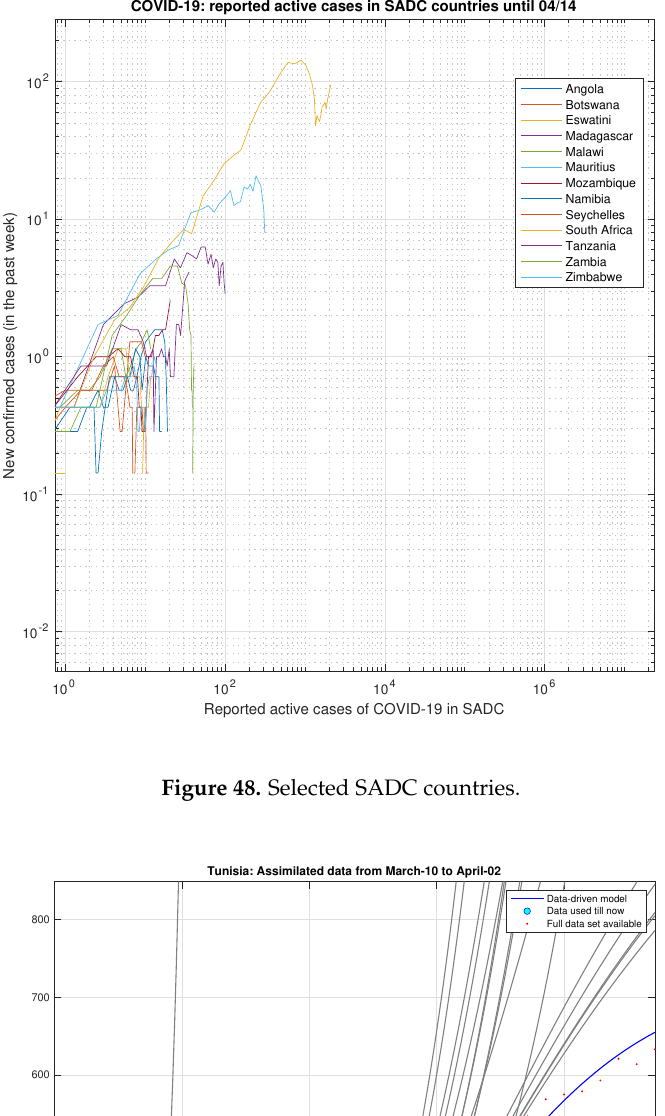
Figure 48. Selected SADC countries.